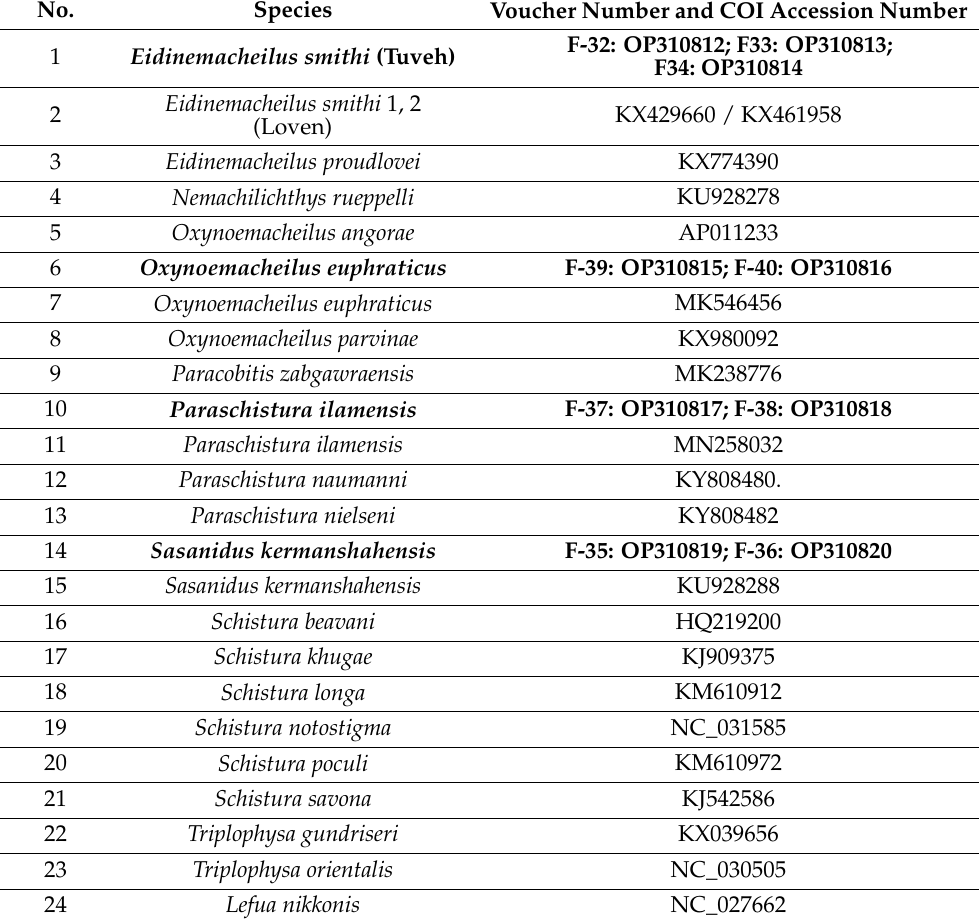
Table 1. Taxonomic and gene information (GenBank accession numbers) data for the taxa used in our analyses. Original sequence data are indicated in bold